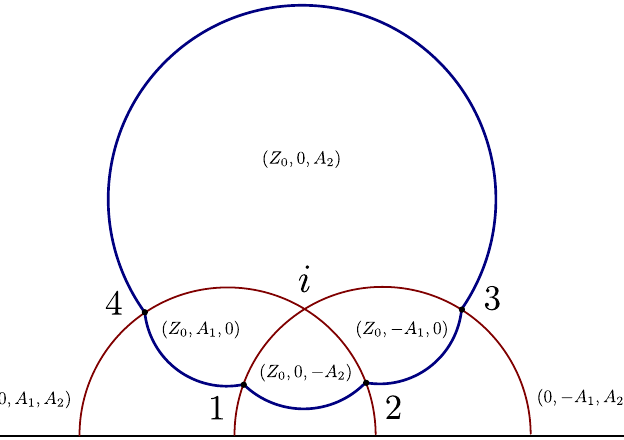
Figure 22 . Out-of-time ordered four-point